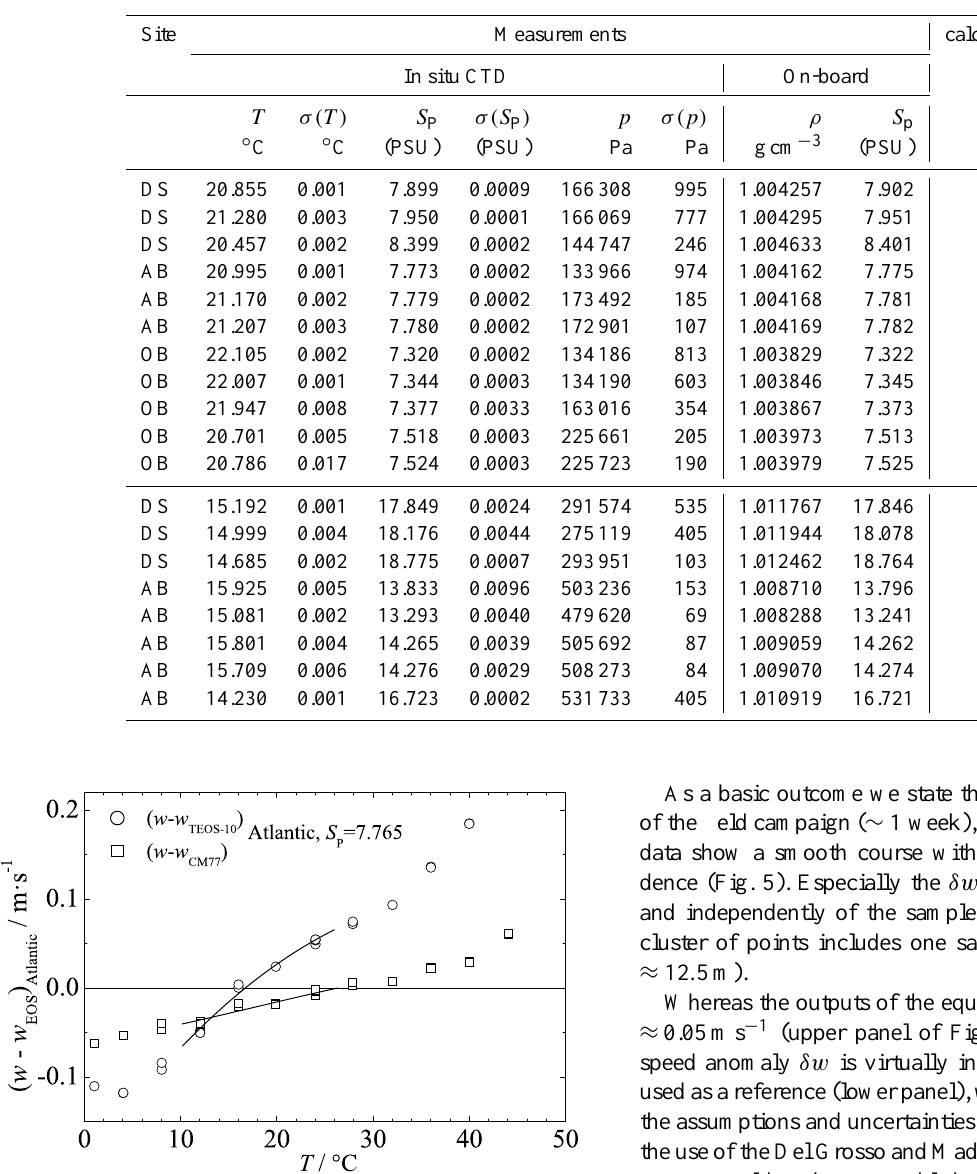
Table 3. CTD data (averages of 2 min recordings at constant depths) at three sites in the Baltic Sea (see Fig. 2) in August 2014, including standard deviations; p : hydrostatic plus air pressure. Three right columns: on-board density and salinity measurements as averages of two samples taken in parallel to the CTD measurements; calculated salinity anomaly δS A based on on-board measurements.